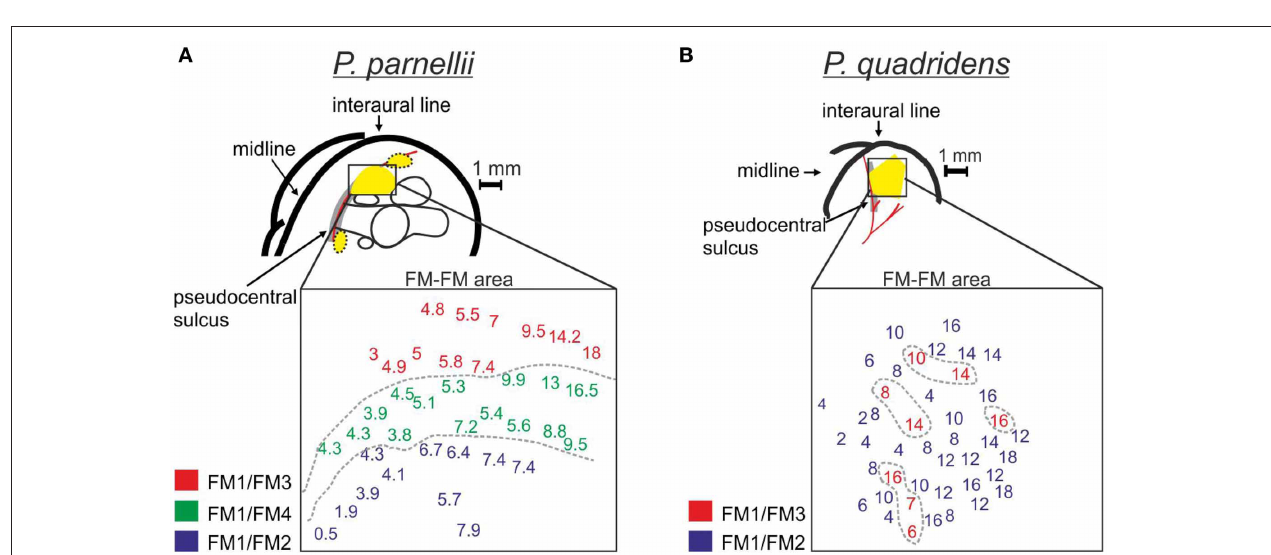
harmonic. Insect size was calculated according to the maximum and minimum frequencies in each harmonic after Macías et al. (2006). It is suggested that each neuron could play a role in prey categorization according to size.